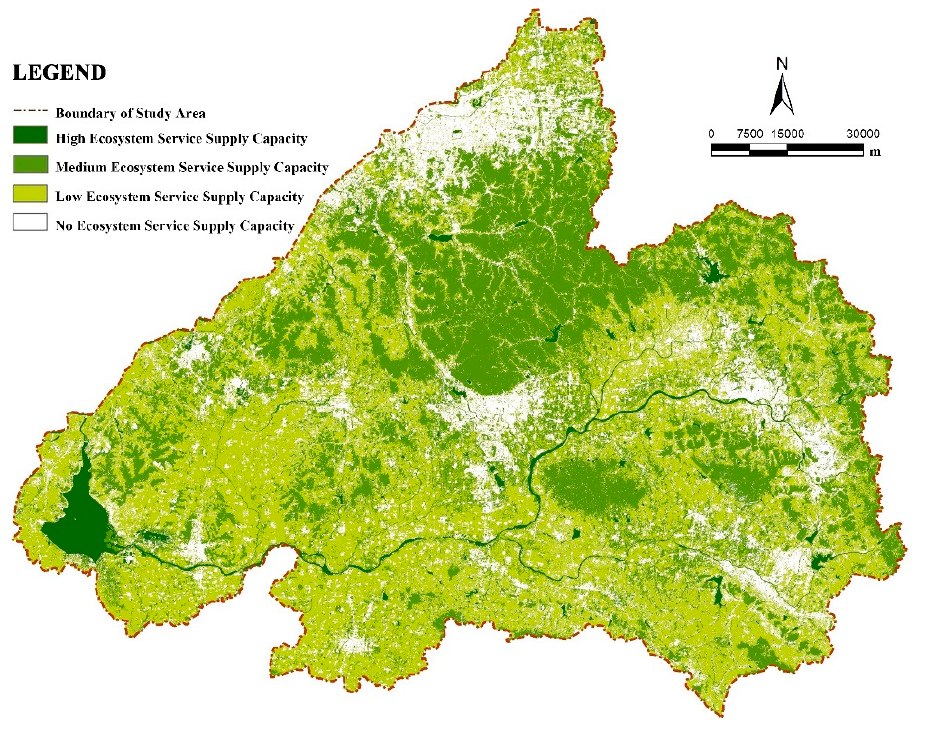
Figure 5. Classification of ecosystem service value in Taishan area.